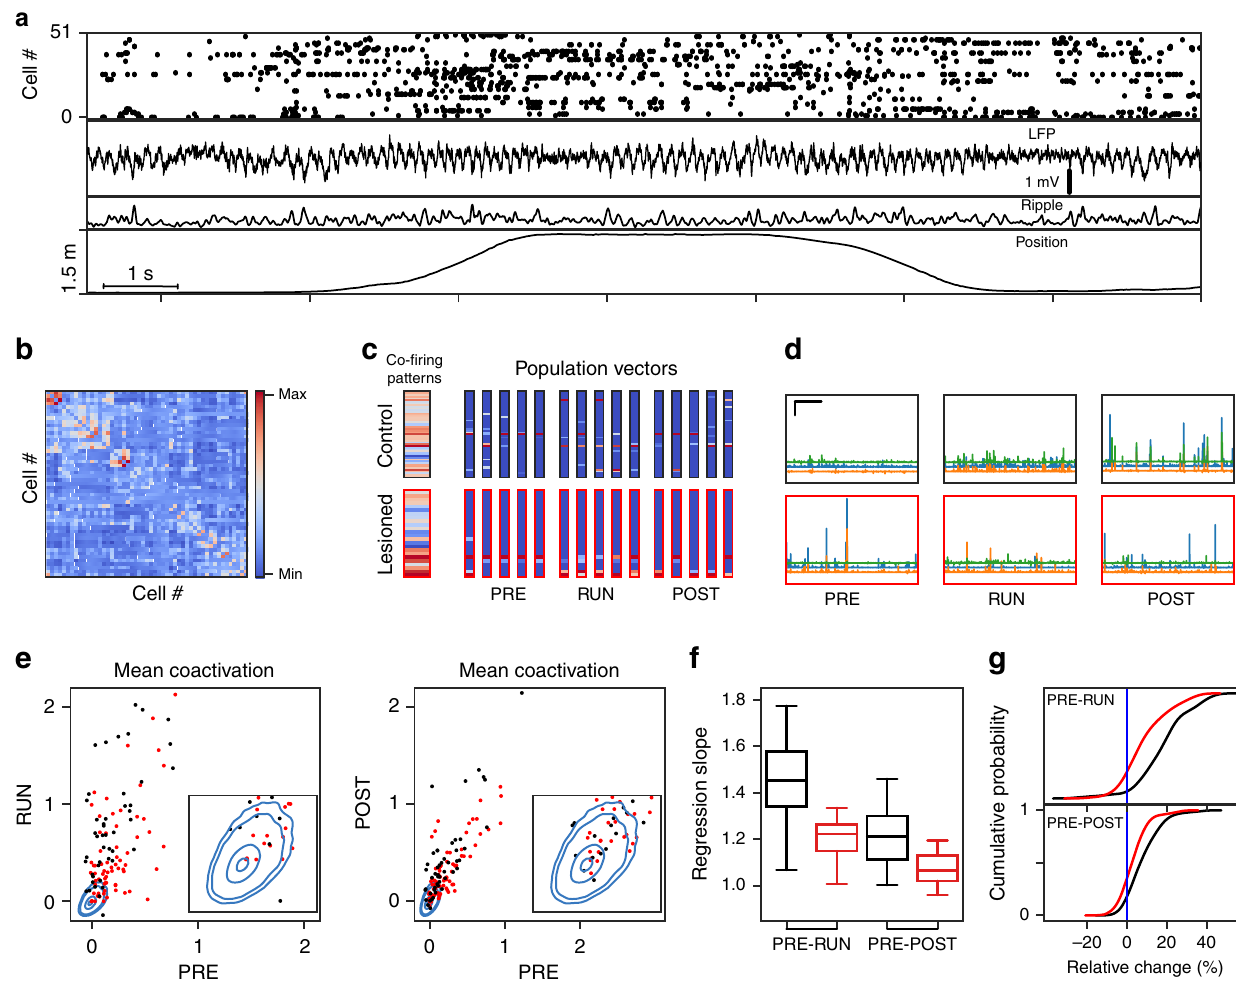
Fig. 1 Pattern co-activation. a Example of recorded hippocampal activity from a control animal during a RUN session. From top to bottom: Raster of single unit-activity of 51 cells, local fi eld potential, ripple power (in a.u.), and position on linear track. b Covariance matrix obtained from z -scored population rate vectors within theta cycles throughout the RUN session from A. c Two examples of signi fi cant eigenvectors (wide columns) from the covariance matrix and fi ve matching example pattern vectors from the PRE, RUN, and POST rest sessions. Red frames indicate examples from a lesioned animal. Colors as in b . d Example of three co-activation traces (scalar product between patterns and eigenvectors) as a function of time during PRE and POST rest epochs (scale bars: horizontal 100 s, vertical 50 standard deviations, traces are offset parallel to y -axis for visual distinction). e Session-wise mean RUN (left) and POST (right) co-activation traces vs. mean PRE co-activation traces for all signi fi cant eigenvectors from control animals (black, Ctr.) and MEC-lesioned animals (red, Les.). The blue contours (1, 5, 50, and 90%) delineate isoclines of the null distribution obtained from 50,000 random permutations of cell indices. f Session-wise regression slopes of PRE vs. RUN and PRE vs. POST. Whiskers represent 1.5 interquartile range. Comparison between animal